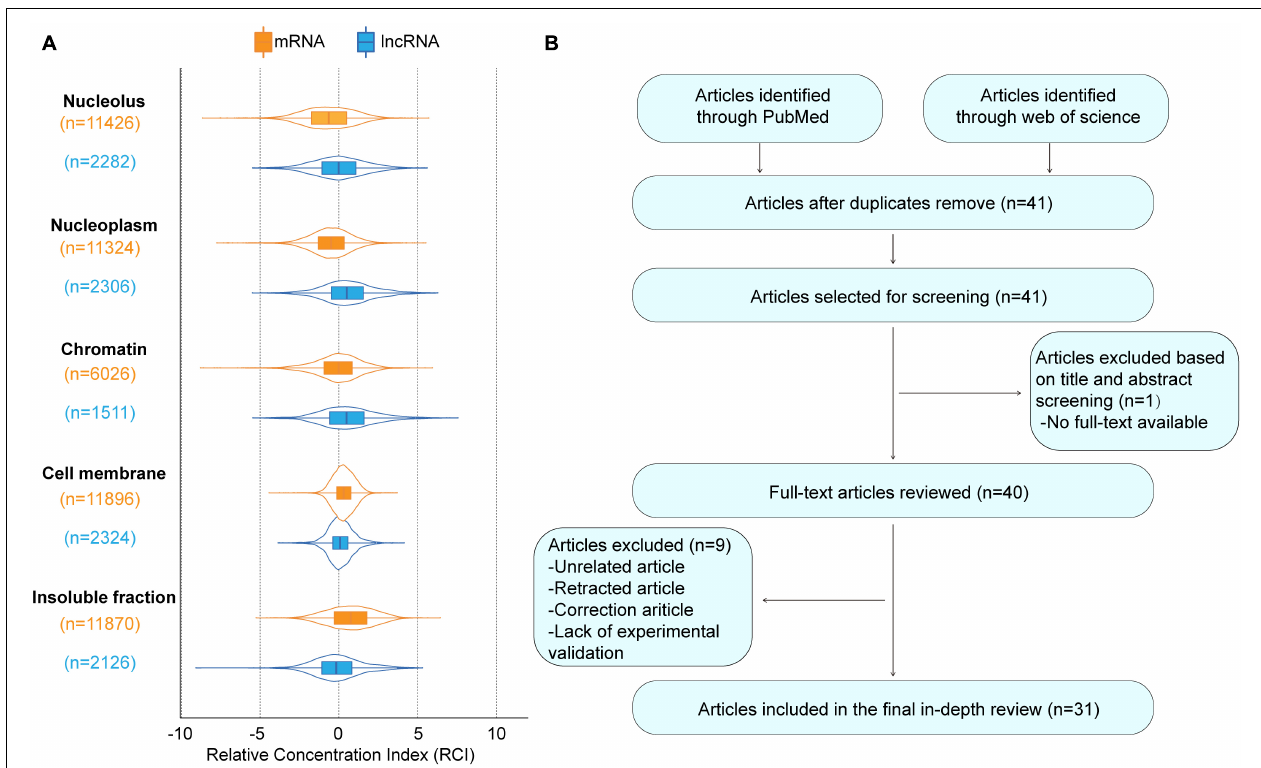
FIGURE 1 | The basic information of MCM3AP-AS1. (A) The subcellular localization plot of MCM3AP-AS1 displayed by lncATLAS database. For K562 cells, subnuclear and sub-cytoplasmic fractions were available and Relative Concentration Index (RCI) for all lncRNAs and mRNAs was computed. Boxplot shows the distribution of these RCI values for each subnuclear and sub-cytoplasmic compartment (“n” indicates total number of genes in a distribution). (B) Flow diagram of the research search and selection process.